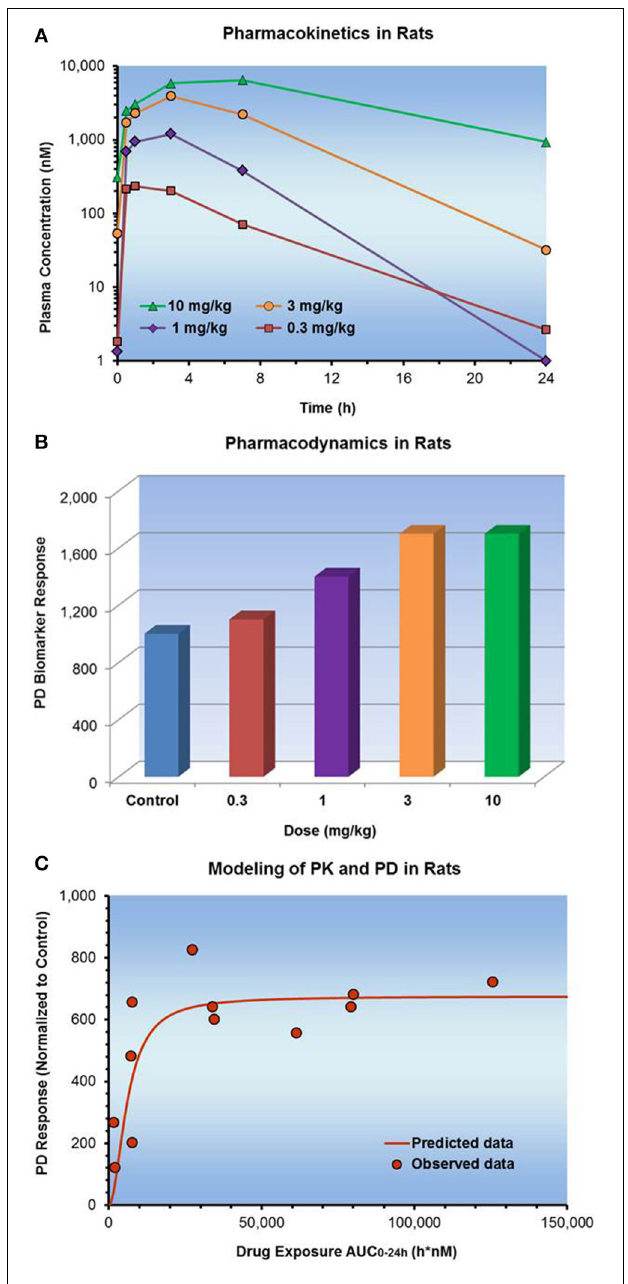
FIGURE 7 | Dose dependent PK and PD observed in a rat model of diabetes. (A) Shows the PK with time, (B) shows the PD with time, and (C) plot of PK vs. PD. There was instantaneous equilibrium between exposure and effect, thus the PK/PD data were modeled using a direct Sigmoidal E max response model.